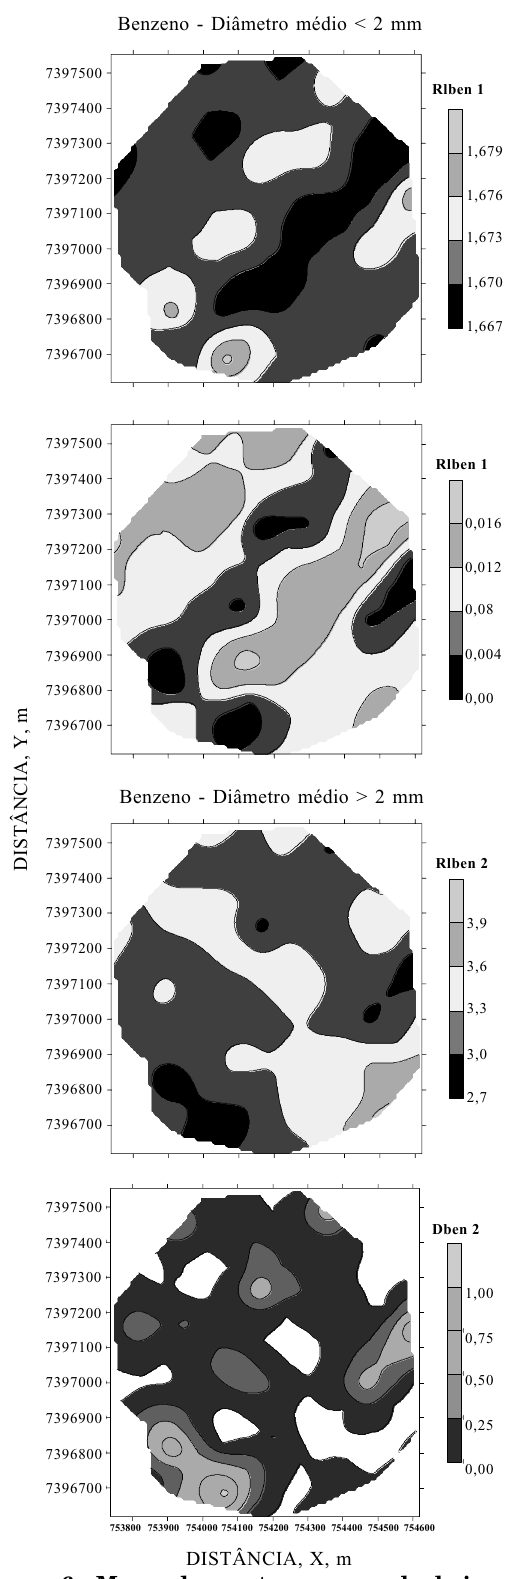
Figura 6. Mapa de contorno usando krigagem ordinária para o maior tamanho de agregado R e para a dimensão da massa fractal D no L pré-tratamento com